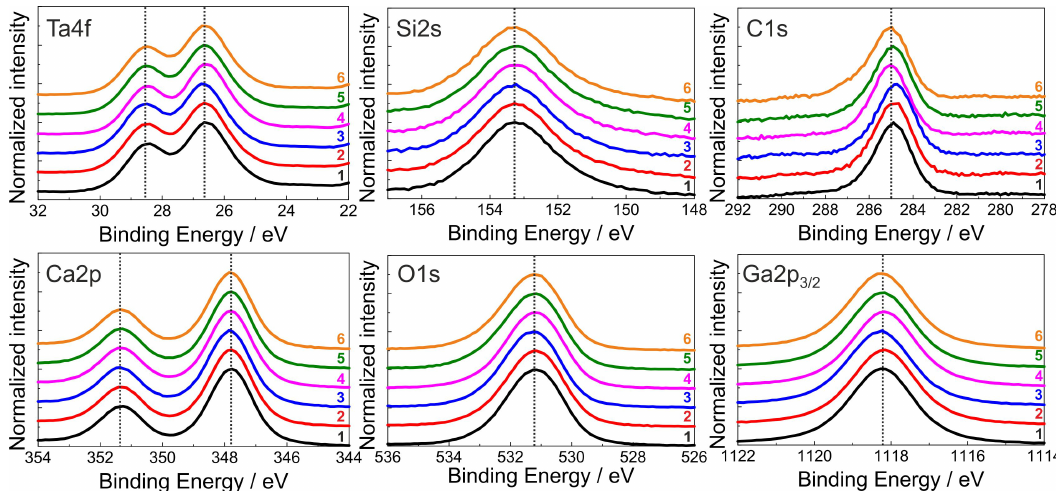
Figure 5. Normalized XPS signals of the elements which form the CTGS substrate (Ca, Ta, Ga, Si, O) and of carbon contamination measured after the various cleaning procedures. The dotted vertical lines serve as guide to visualize the similarity between the measured